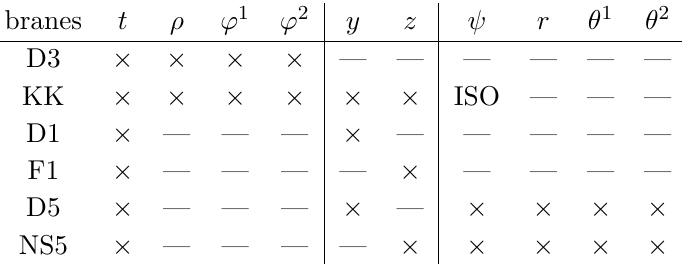
Table 4 . BPS/8 intersection describing D1-F1-D5-NS5 branes ending on the D3-KK system.